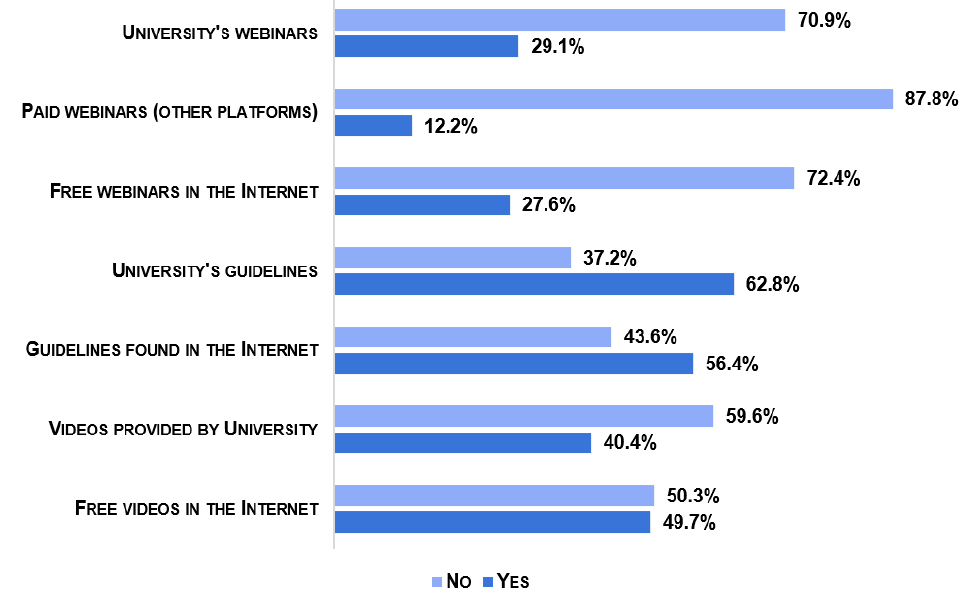
Figure 8. Methods for mastering educational materials.